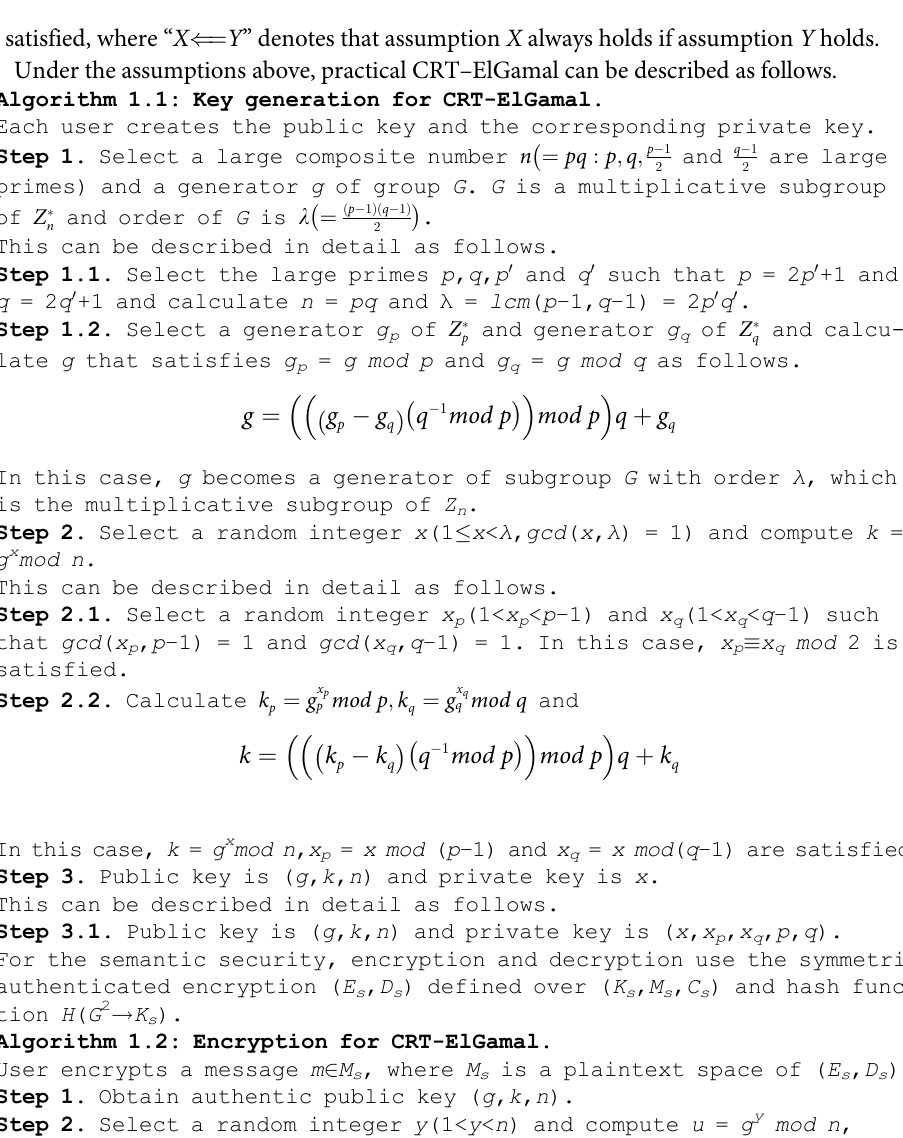
Algorithm 1.2: Encryption for CRT-ElGamal